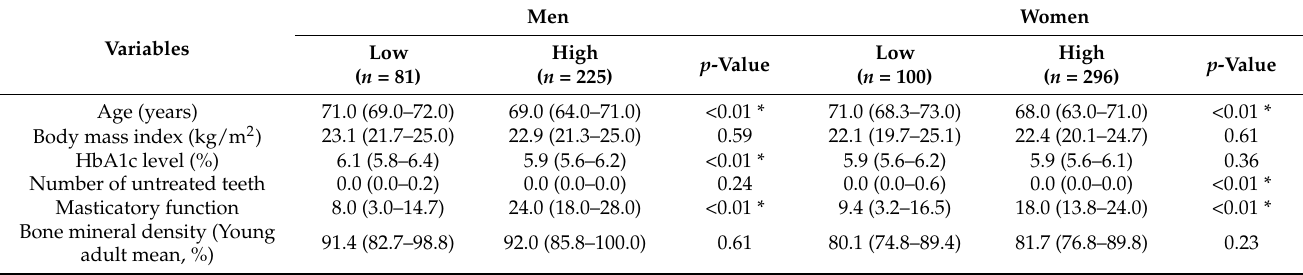
Table 2. Comparison of each variable between the High and Low